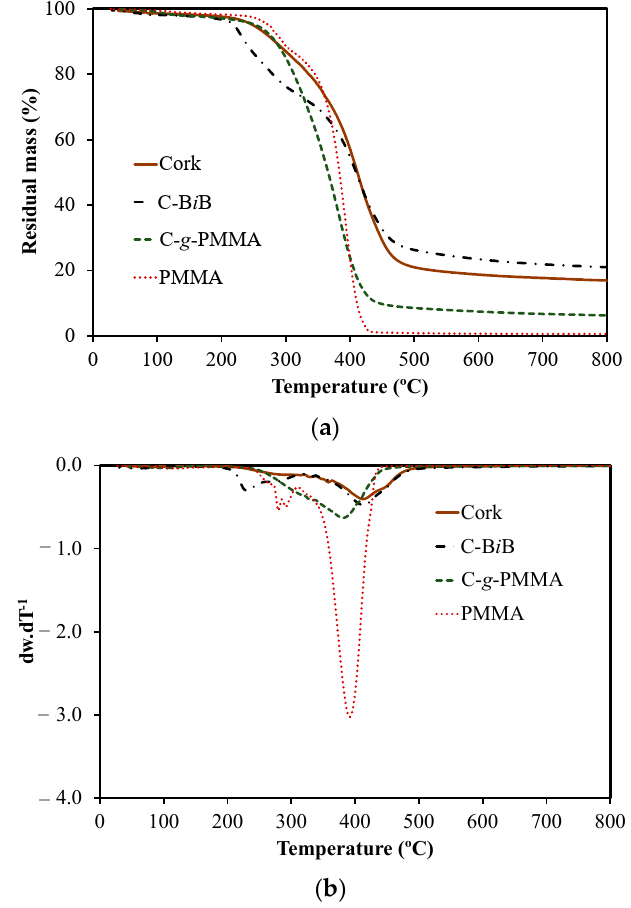
Figure 4. Thermal analyses: thermogram ( a , b ) first derivative of weight loss as a function of temperature of Cork, C-B i B, C- g -PMMA and PMMA homopolymer (produced via ATRP). Table 2. TGA features of cork, C-B i B, C- g -PMMA and PMMA homopolymer.